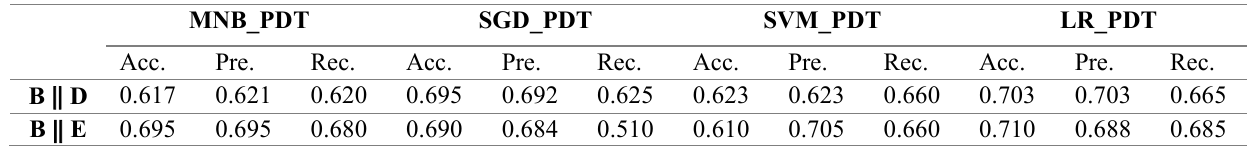
Table 8. CDSC results using the proposed strategy (label extraction using PDT